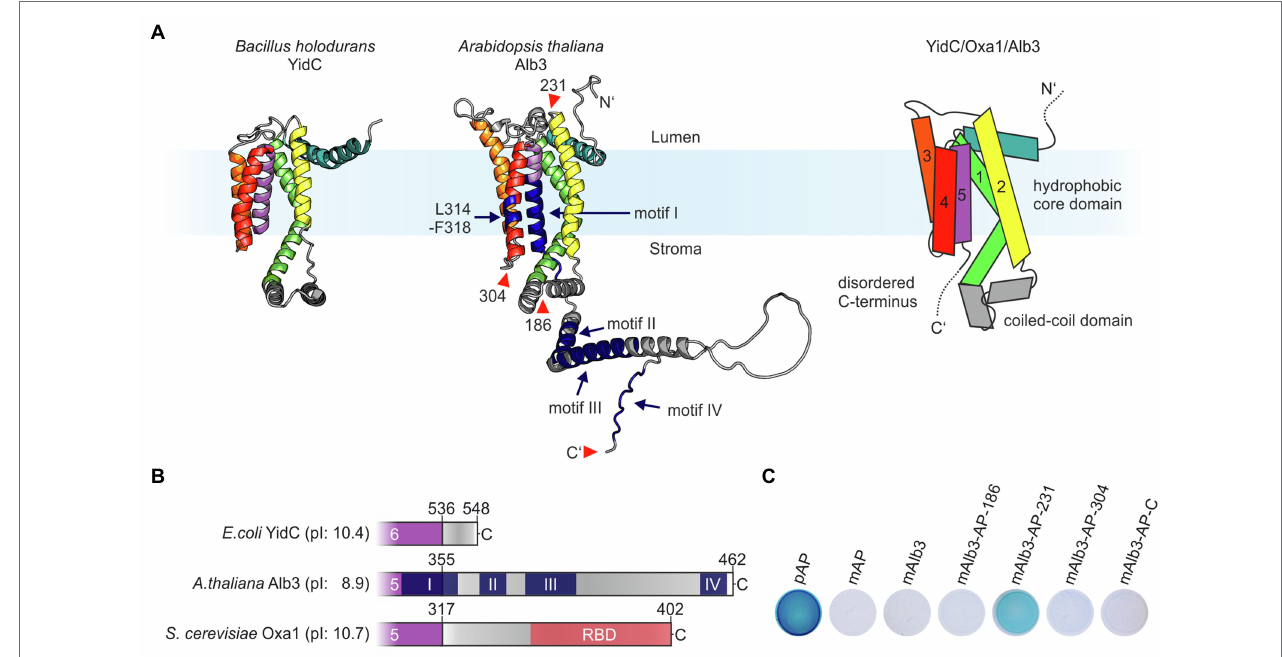
FIGURE 1 | Proteins of the Oxa1 family share common structural features. (A) Comparison of the crystal structure of YidC from Bacillus halodurans (left; PDB: 3WO6; Kumazaki et al., 2014a) and the AlphaFold model of Arabidopsis thaliana Alb3 without signal peptide (middle; model: AF-Q8LBP4-F1; Jumper et al., 2021). Regions in the structural model of Alb3 highlighted in dark blue indicate conserved sequence motifs involved in cpSRP43 binding (residues 314–318 within the fourth TMH and motifs II and IV in the C-terminal region); the conserved motifs I and III are also highlighted in dark blue. The red arrowheads indicate the alkaline phosphatase (AP) insertion sites mentioned in C . Right: scheme of the predicted topology of the hydrophobic core region of members of the Oxa1 family encompassing five transmembrane helices. (B) Features of the C-terminal sequences of members of the Oxa1 family. The start of the C-terminal regions were defined to the first residue after the last transmembrane helix according to the crystal structure of Escherichia coli YidC (PDB: 3WVF; Kumazaki et al., 2014b) and the Alphafold models of A. thaliana Alb3 (see above) and Saccharomyces cerevisiae Oxa1 (model: AF-P39952-F1; Jumper et al., 2021). Theoretical pI-values for the indicated C-terminal peptide sequences were calculated using ExPASy ProtParam. Prominent sequence motifs are marked. I, II, III, and IV: conserved motifs of the Alb3 C-terminal region (Falk et al., 2010); RBD: conserved helical ribosome binding domain of the Oxa1 C-terminal region (Jia et al., 2003). (C) Alkaline phosphatase (AP) activity of bacterial cells carrying expression plasmids coding for different Alb3-AP fusions to identify membrane protein topology. AP was fused into mature Alb3 at amino acid positions 186 (mAlb3-AP-186), 231 (mAlb3-AP-231), 304 (mAlb3-AP-304), and to the C-terminus (mAlb3-AP-C). Control cells expressed the precursor of AP (pAP), mature AP (mAP) and mAlb3. The positions of the fusions are indicated schematically in A (red